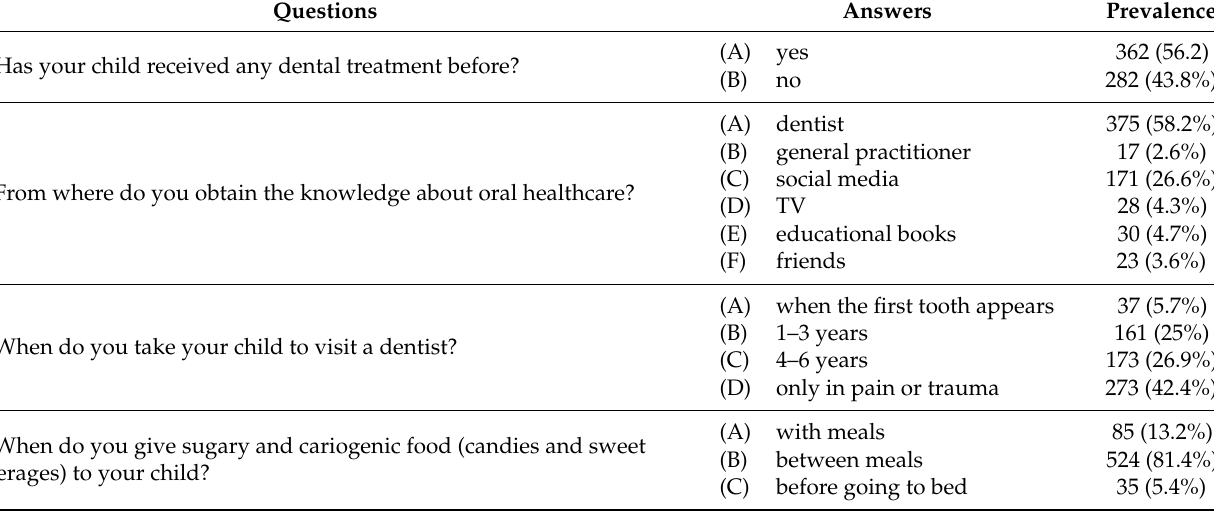
Table 3. Participants’ behavior regarding oral health and